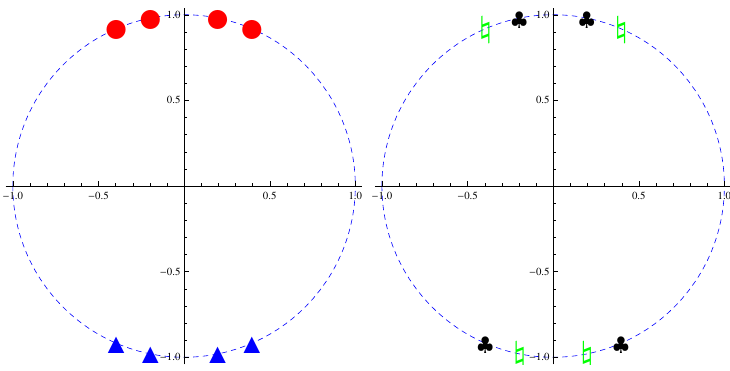
Figure 7 . The eigenvalue distribution of (cid:10) F for su (4) with two adjoint and two (200) fermions. Di(cid:11)erent vacua are labeled by di(cid:11)erent markers and distinct colors. The theory has 4 degenerate minima and broken Z 2 center. Every pair of minima is exchanged under Z 2 . In order to reduce clutter, we plot the eigenvalues of (cid:10) F for the related vacua (by Z 2 transformation) on two separate panels. The right and left panels are not exchanged under any symmetry, and in general, the degeneracy between the two panels could be lifted after taking higher order loops into account. In the left panel we have tr F (cid:10) = (cid:6) i 3 : 797 for the red (circle) and blue (triangle) vacua, respectively. In the right panel we have tr F (cid:10) = (cid:6) i 0 : 124 for the Green (musical note) and black (club suit) vacua, respectively. All vacua break C , P , and T